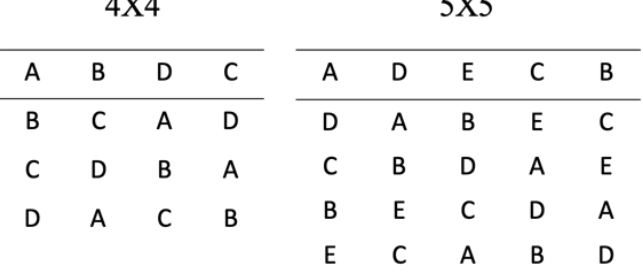
Figure 3. Latin square of each treatment is repeated n times so that it appears once in each row.